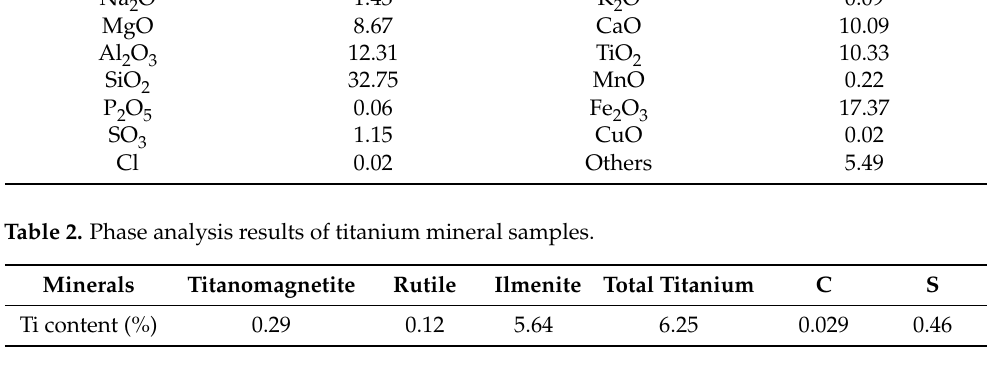
Table 3. Particle size, density and TiO 2 metal distribution of ore sample.